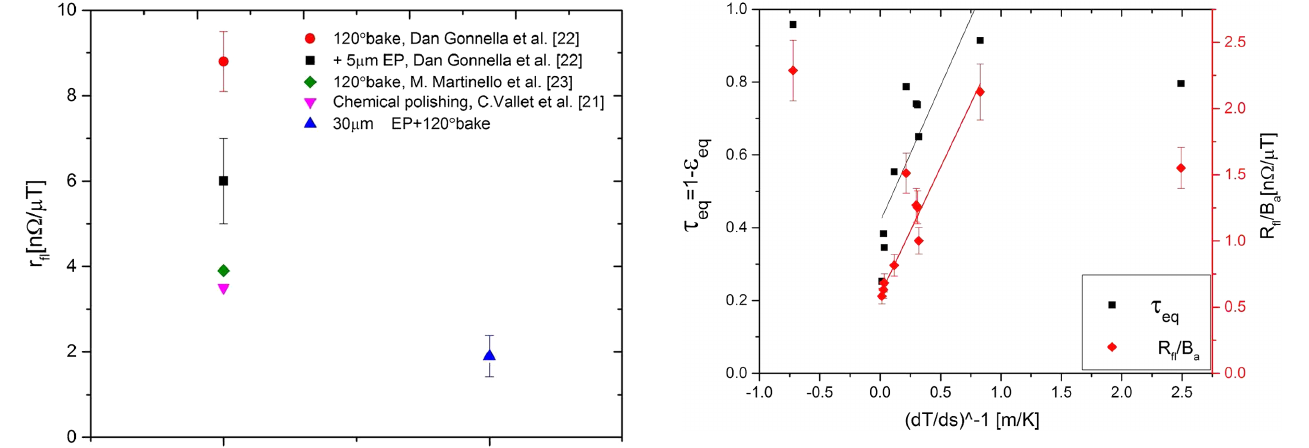
FIG. 7. The magnetic flux trapping ratio τ normalized by an applied field as functions of the reciprocal of dT=ds for all the data shown in Table